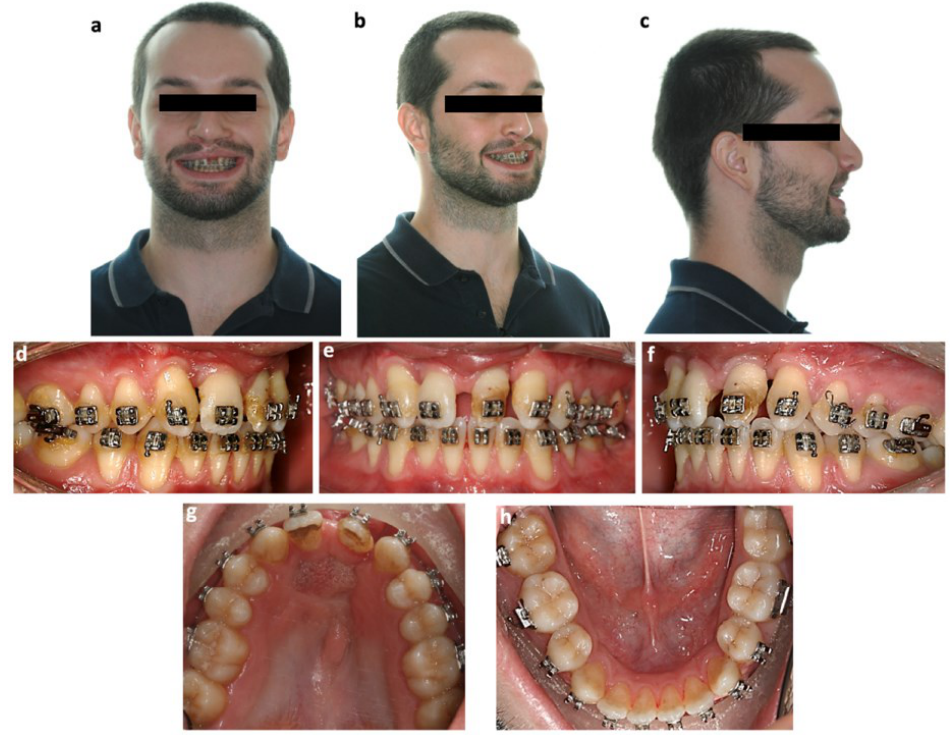
Figure 5. Post-orthodontic treatment photographs: extraoral ( a ) frontal view; ( b ) 3/4 lateral view; ( c ) profile and intraoral ( d ) right side; ( e ) frontal; ( f ) left side; ( g ) superior arch; ( h ) inferior arch.